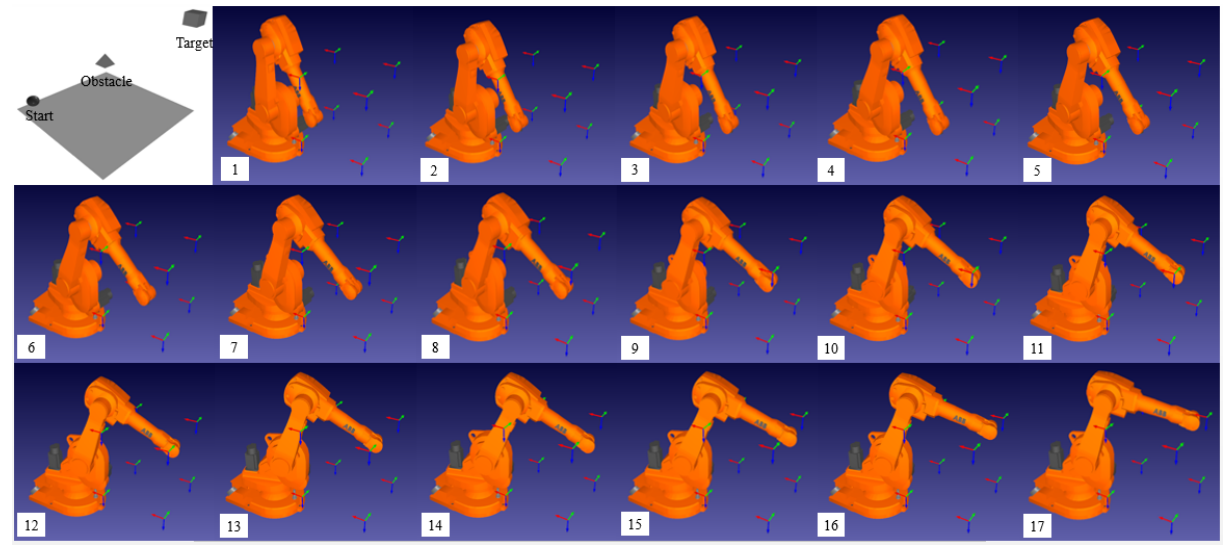
Figure 7. Simulation results in a RoboDK software: ( 1 – 17 ). The end ‐ effector of a robot arm starts moving from a start point (Sphere) and avoid an obstacle point (Pyramid). Then reaches a target point (Cube).